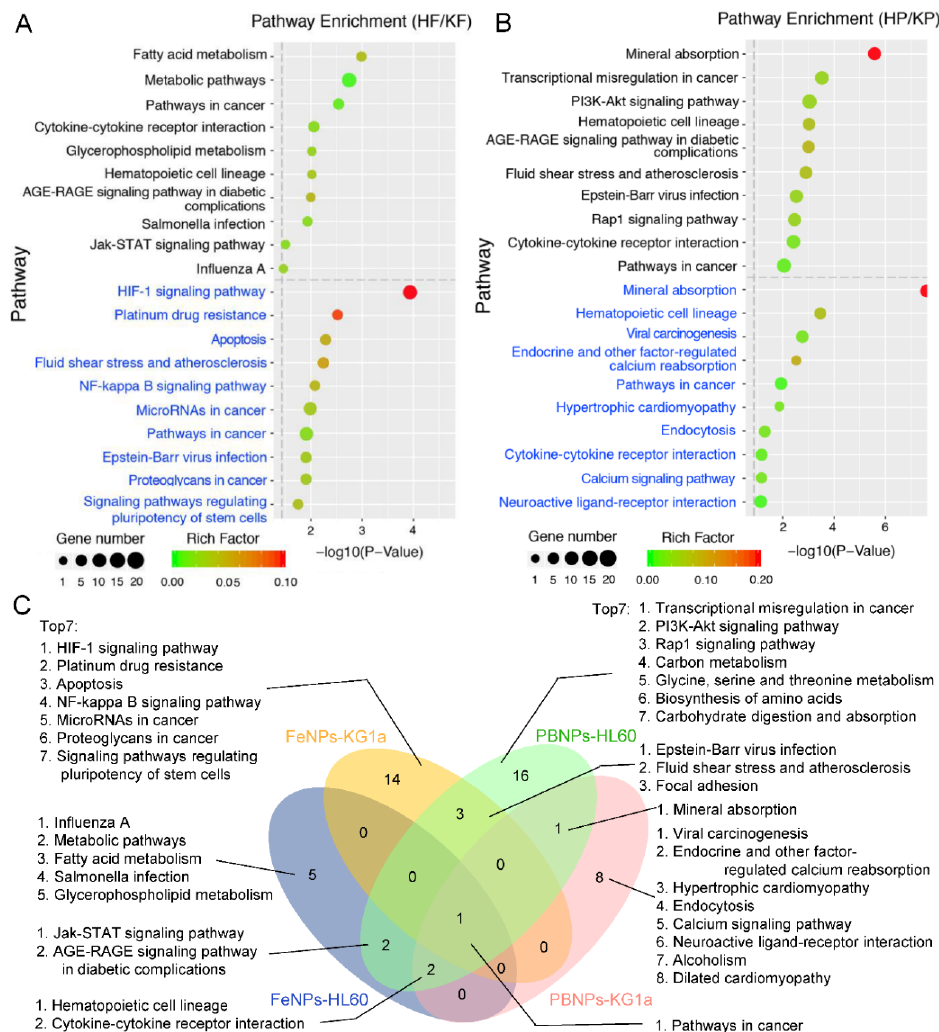
Figure 6. Comparative Kyoto Encyclopedia of Genes and Genomes (KEGG) pathway enrichment analysis of the DEGs ( p < 0.05): ( A ) comparative top 10 enriched pathways of HL60 and KG1a treated with FeNPs and ( B ) comparative top 10 enriched pathways of HL60 and KG1a treated with PBNPs. The pathways in black and blue were HL60 and KG1a cells, respectively. ( C ) Four-way Venn analysis of all KEGG pathways in four groups. The detailed information of all KEGG pathways is shown in File S3 (Supplementary Materials). HF, FeNP-treated HL60 cells; HP, PBNP-treated HL60 cells; KF, FeNP-treated KG1a cells; and KP, PBNP-treated KG1a cells. In HF, the fatty acid metabolism was the most significantly enriched pathway, in which the ACACA, FADS1, and FADS2 genes play important roles in cell membrane formation and repair. The metabolic pathways mainly involved in lipid metabolism and glycerophospholipid metabolism were also enriched in HF. In contrast, the HIF-1 signaling way was most prominently enriched in KF, which consisted of CDKN1A, FLT1, HMOX1, IGF1R, PLCG2, TFRC, STAT3, LDHA, ENO1, PGK1, and ELOB genes (Figure S4). This signaling way can mediate adaptive responses to reduced oxygen availability; it was crucial for angiogenesis, vascular reactivity and remodeling, glucose and energy metabolism, inflammation, tumor, and iron homeostasis [48]. The hypoxia and free radicals can activate the function of HIF-1 [49]. By producing ROS, the HIF-1 signaling way was activated by FeNPs in KG1a. PLCG2 was induced by ROS to affect the IP3/DAG pathways, the ubiquitination of